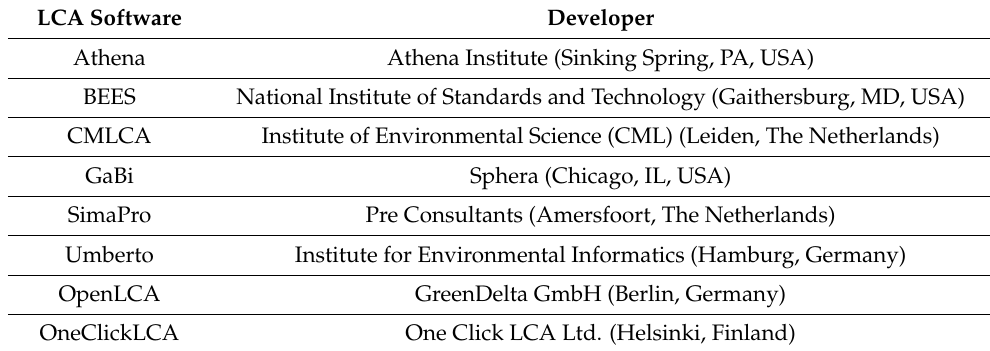
Table 2. LCA software